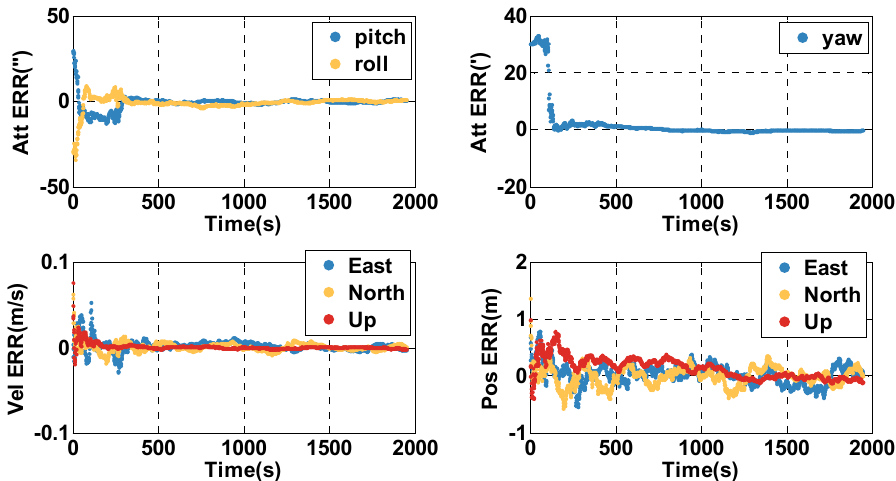
Figure 4. The position (Pos), velocity (Vel), and attitude (Att) errors (ERR) in the open-sky case by applying the MTF method.